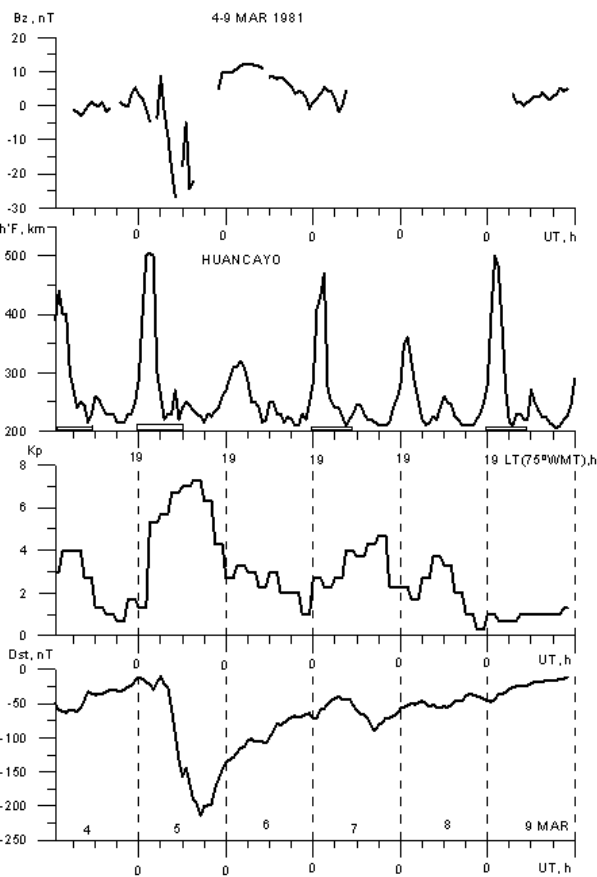
Fig. 3. Storm 3: 4–9 March 1981, (Category 1). The IMF B z component, the ionospheric F -layer height h 0 F at Huancayo, K p and D st indices are presented. The scintillation patch durations for Huancayo are shown along the time axis of the h 0 F figure.